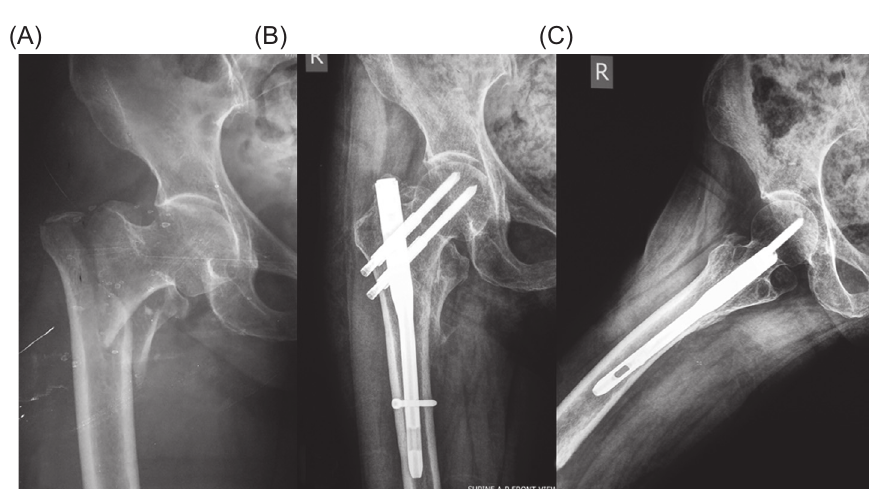
Figure 1. (A) Anteroposterior radiograph of the right hip of a 65-year-old woman shows an AO/OTA-31-A2 fracture. (B) Anteroposterior and (C) lateral radiographs of the right hip one year after surgical treatment show fracture healing. The patient was alive with excellent function.